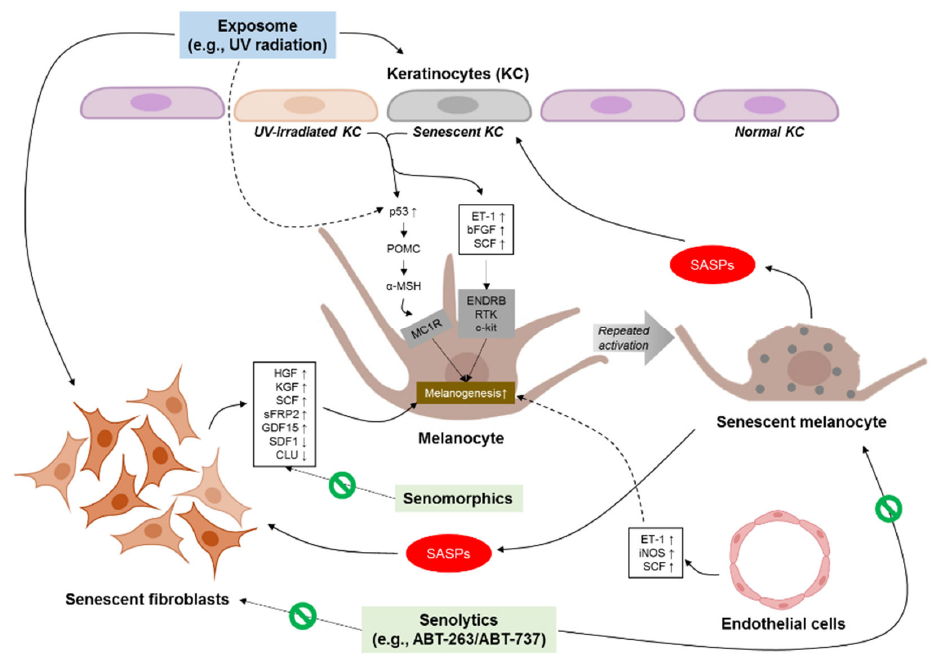
Figure 1. Cellular crosstalk between melanocytes and neighboring cells in skin-aging pigmentation. UV, ultraviolet; SASP, senescence-associated secretory phenotype, POMC, p53-mediated upregulation of proopiomelanocortin; α -MSH, α -melanocyte-stimulating hormone; MC1R, α -MSH stimulates the melanocortin 1 receptors; ET-1, endothelin-1; bFGF, basic fibroblast growth factor; SCF, stem cell factor; ENDRB, endothelin B receptor; RTK, receptor tyrosinase kinase; HGF, hepatocyte growth factor; KGF, keratinocyte growth factor; sFRP2, secreted frizzled-related protein 2; GDF15, growth differentiation factor 15; SDF1, stromal-derived factor 1; CLU, clusterin; iNOS, inducible nitric oxide